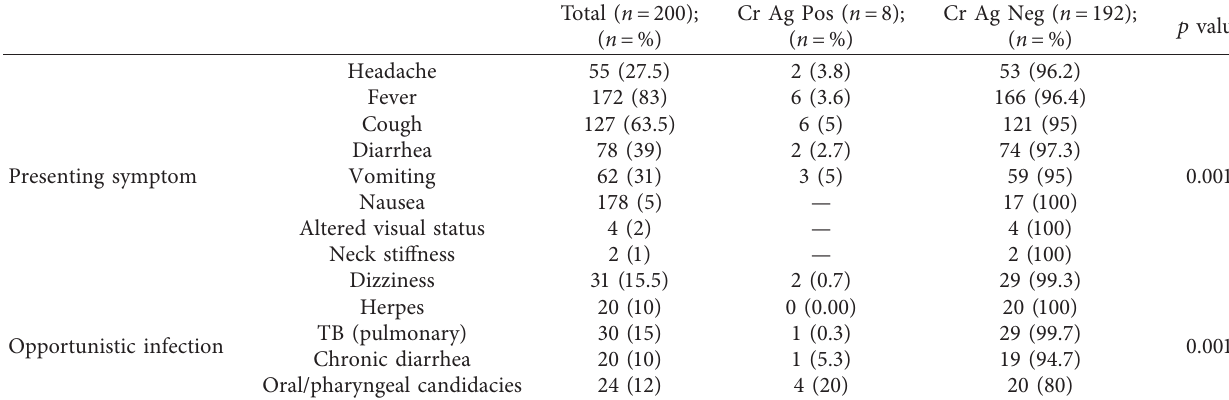
Table 2: Presenting symptoms and concurrent opportunistic infection